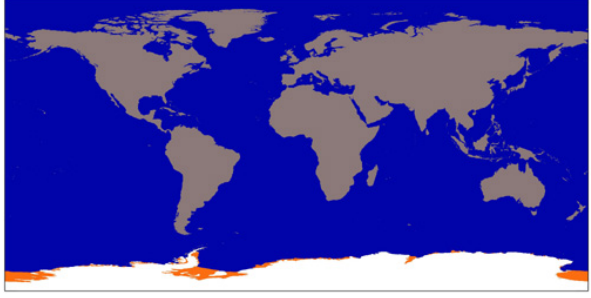
Figure 7. Global surface type mask in RTopo-1. Blue = ocean, white = grounded ice, orange = ice shelf, grey = bare land surface.